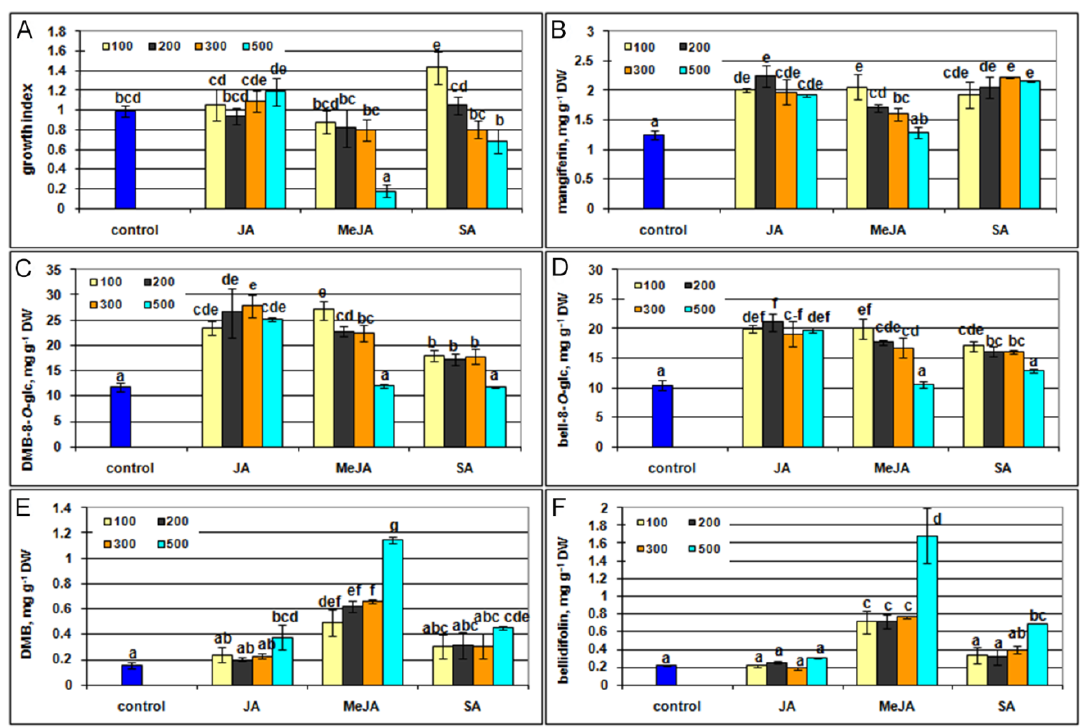
Figure 9. Effect of elicitors jasmonic acid (JA), methyl jasmonat (MeJA) and salicilic acid (SA) at increasing concentrations (100, 200, 300, and 500 µM) on the growth index and xanthone production of shoot cultures of G. lutescens (line 5). Growth index ( A ), mangiferin ( B ), DMB-8- O -glc ( C ), bell-8- O -glc ( D ), DMB ( E ), and bellidifolin ( F ) content. Data represent means ± SE of four to seven biological replicates ( n = 4–7). Values denoted by the same letter are not significantly different according to the Fisher’s LSD test at p ≤ 0.05 following ANOVA multifactorial analysis.